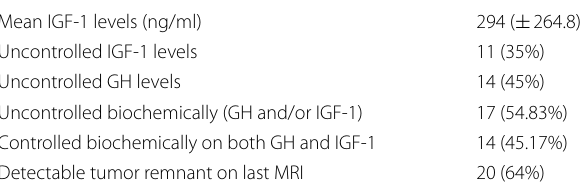
IGF-1 Insulin growth factor-1, GH Growth hormone, MRI Magnetic resonance imagining. For the variables expressed as means we expressed the standard deviations in